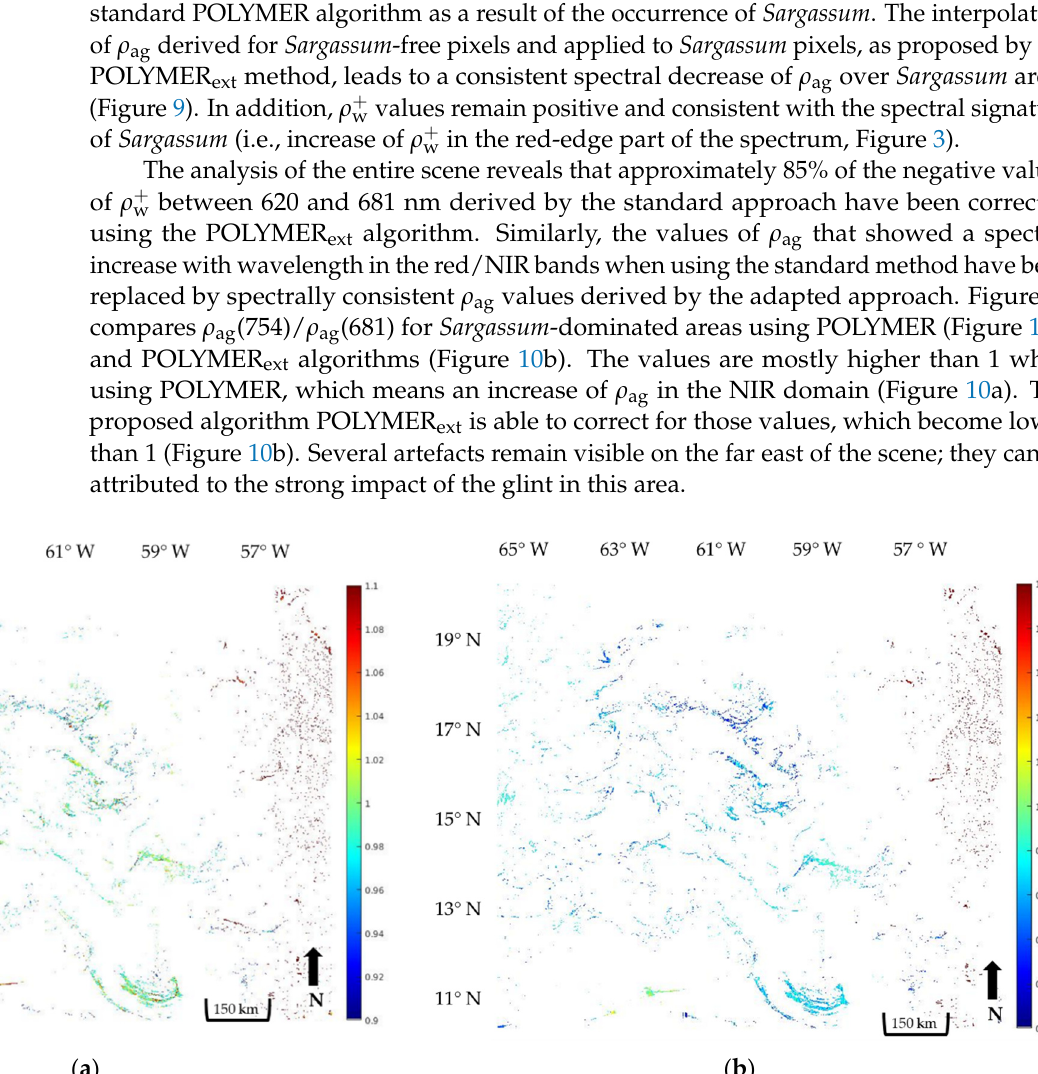
Table 1. Percentage of negative reflectance values corrected between (620 and 681 nm) by using POLYMER ext on Sargassum- dominated areas.